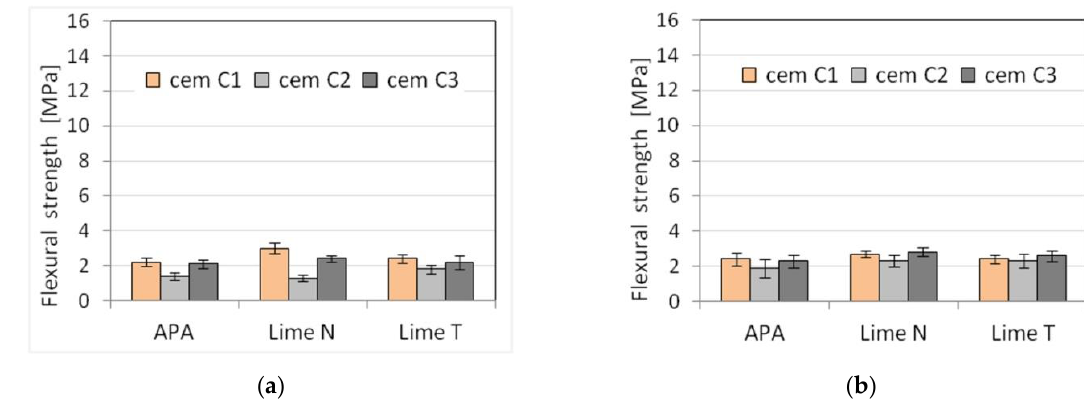
Figure 8. Influence of the cement type on flexural strength of ( a ) plaster, ( b ) masonry mortars. Table 5. Results of tests of the influence of cement type on properties of plaster.